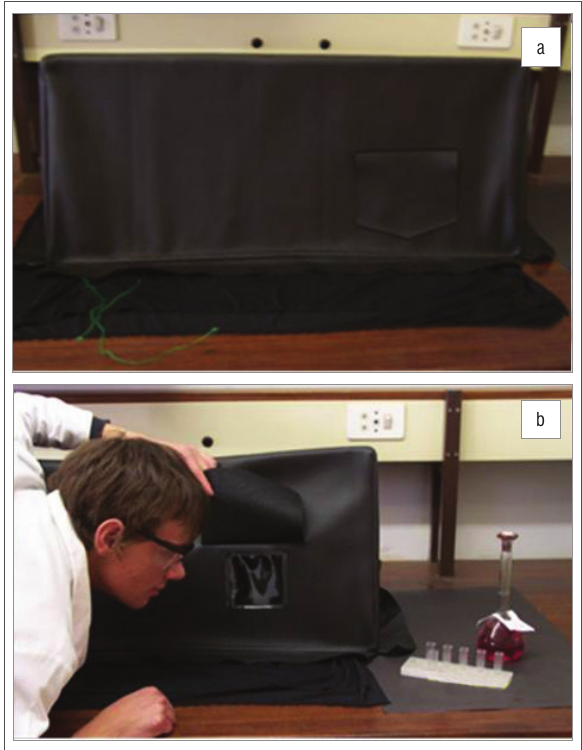
Figure 5: Housing of the spectrophotometer: (a) a black tent-like cover maintains the SpecUP in darkness during operation and (b) a clear plastic window enables the spectrophotometer components to be viewed.